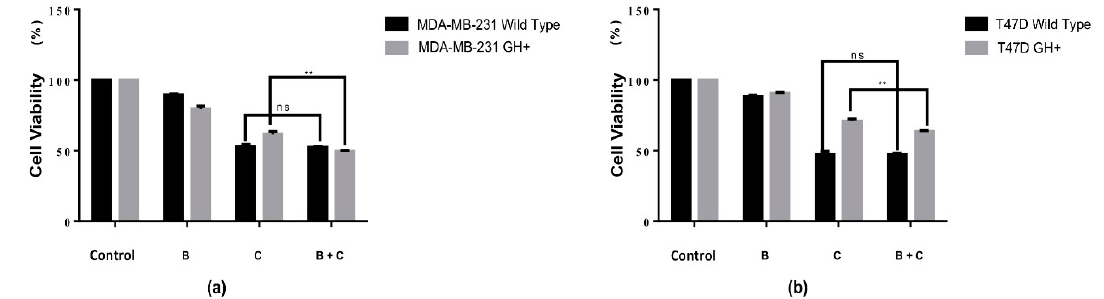
Figure 3. Effect of bafilomycin on curcumin-induced cell viability loss. Determined dose of curcumin (25 µ Μ for MDA-MB-231 and 20 µM for T47D cells) for 24 h treatment with/without Bafilomycin (50 nM) in ( a ) MDA-MB-231 wild type and GH+ and ( b ) T47D wild type and GH+ and MTT cell viability assay was performed. The columns represent mean ± S.D. of two independent experiments and at least 3 replicates. B: Bafilomycin, C: Curcumin, B + C: Bafilomycin and